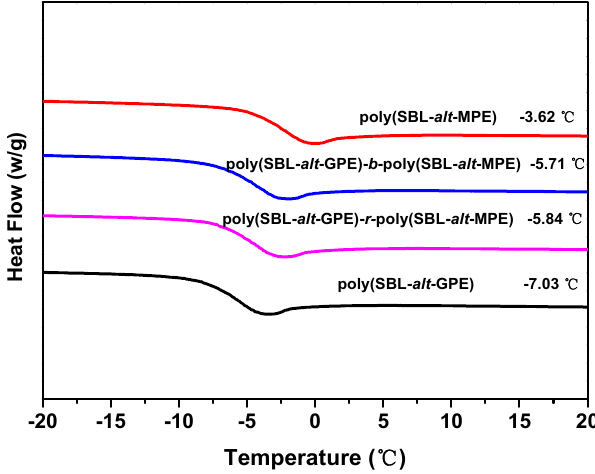
Figure 3. The SEC traces of the pentablock copolymer obtained from the copolymerization of SBL with MPE and GPE alternately.